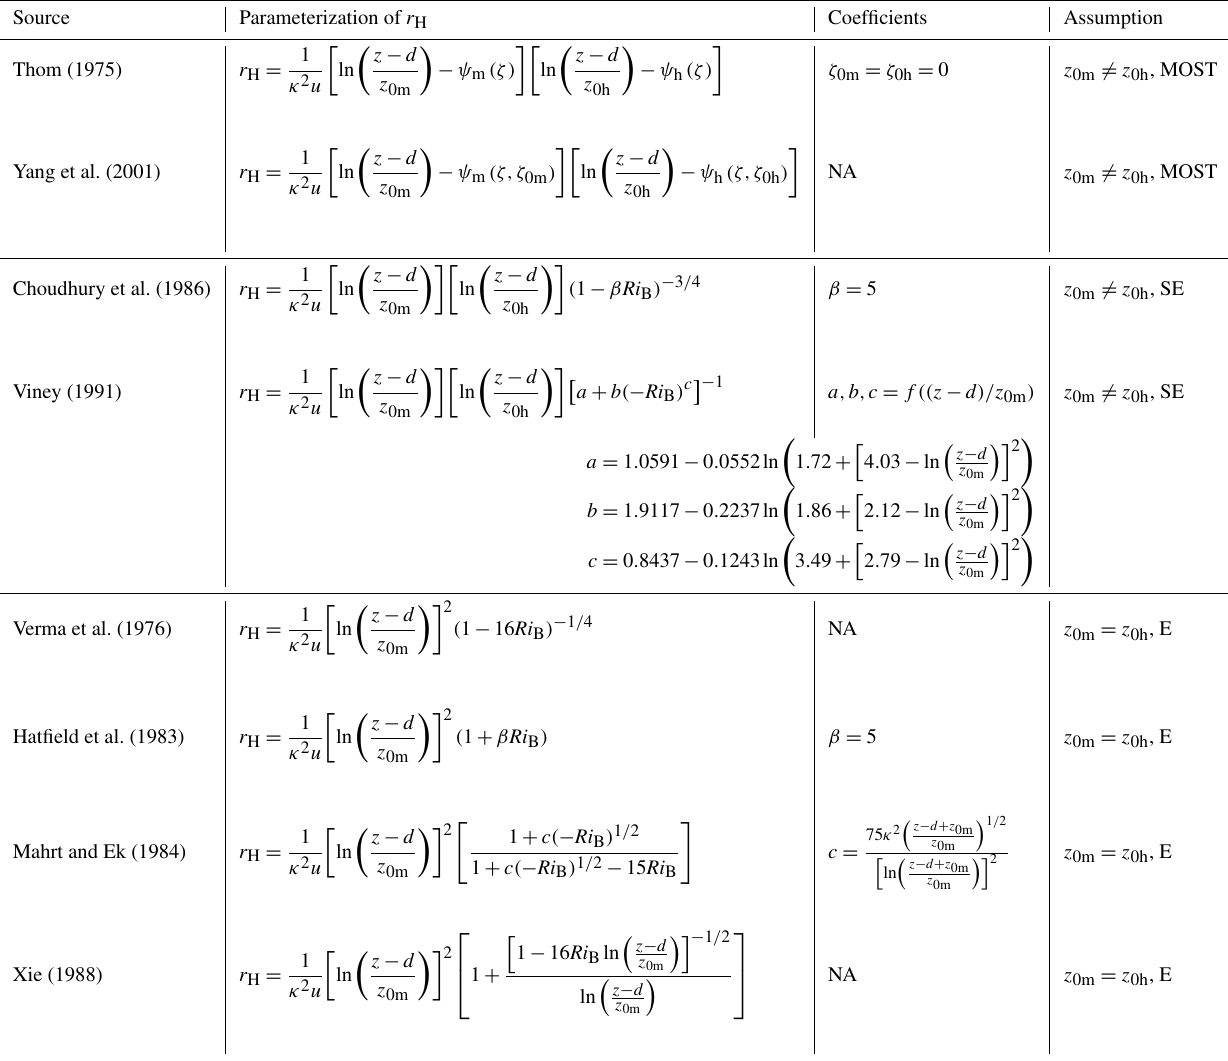
Table 1. Different parameterizations of r H as compiled by Liu et al. (2007). Source Parameterization of r H Coefficients